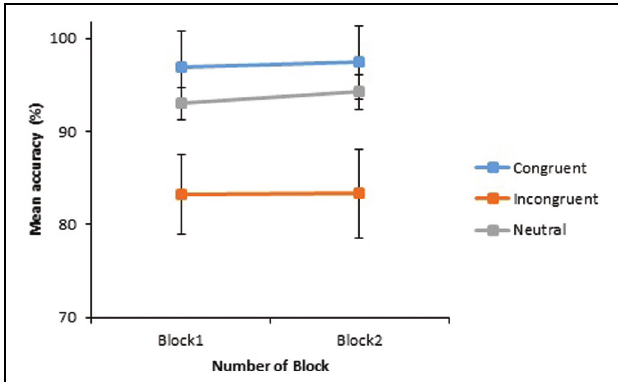
FIGURE 3 | Experiment 2: mean percentages of correct judgments to critical word pairs in Block 1 and Block 2. The vertical axis begins at 70% while error bars indicate the 95% confidence